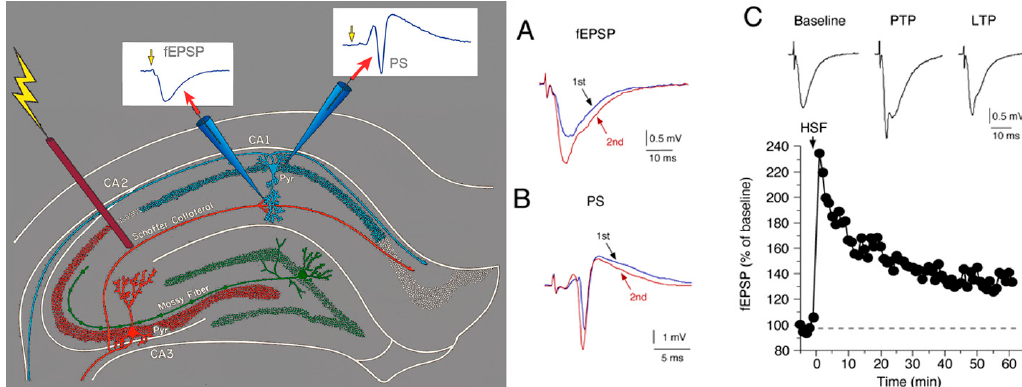
Figure 2. Measurement of synaptic function using extracellular recordings in hippocampal slices. ( Left Panel ) Simplified diagram showing the placement of stimulating and recording electrodes and recorded responses in a field potential recording of synaptic transmission at the Schaffer collateral to CA1 pyramidal neuron synapse in a hippocampal slice. Synaptic transmission is initiated experimentally by electrical stimulation of Schaffer collaterals, axons of the CA3 pyramidal neurons of the hippocampus. Stimulation of the Schaffer collateral elicits a fEPSP in the dendritic region and, depending on the strength of the stimulation, a PS in the somatic region; ( Right panel ) Repetitive stimulation can result in a change in the magnitude of synaptic responses. ( A ) Repetitive stimulation with a 40 ms interval between the first and second stimulation resulted in an enhancement of the fEPSP (2nd) evoked by the second stimulation relative to the fEPSP (1st) evoked by the first stimulation; ( B ) Repetitive stimulation with a 10 ms interval between the first and second stimulation resulted in an enhancement the PS (2nd) evoked by the second stimulation relative to the PS (1st) evoked by the first stimulation in this slice; ( C ) High frequency stimulation (HSF) induces a long-term enhancement of the fEPSP. The graph shows the magnitude of the fEPSP enhancement relative to baseline levels before high frequency stimulation was applied (at the arrow). The initial, large enhancement of the fEPSP is referred to as post-tetanic potentiation (PTP). The delayed, stable increase in the magnitude of the fEPSP is referred to as long-term potentiation (LTP). Representative recordings are shown above the graph.